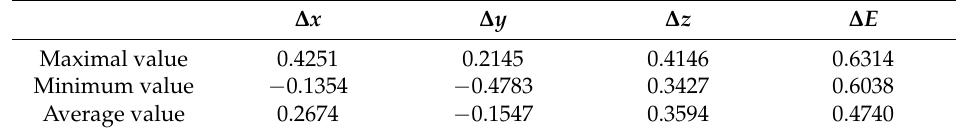
Table 7. Error distribution area of the end-effector after calibration.